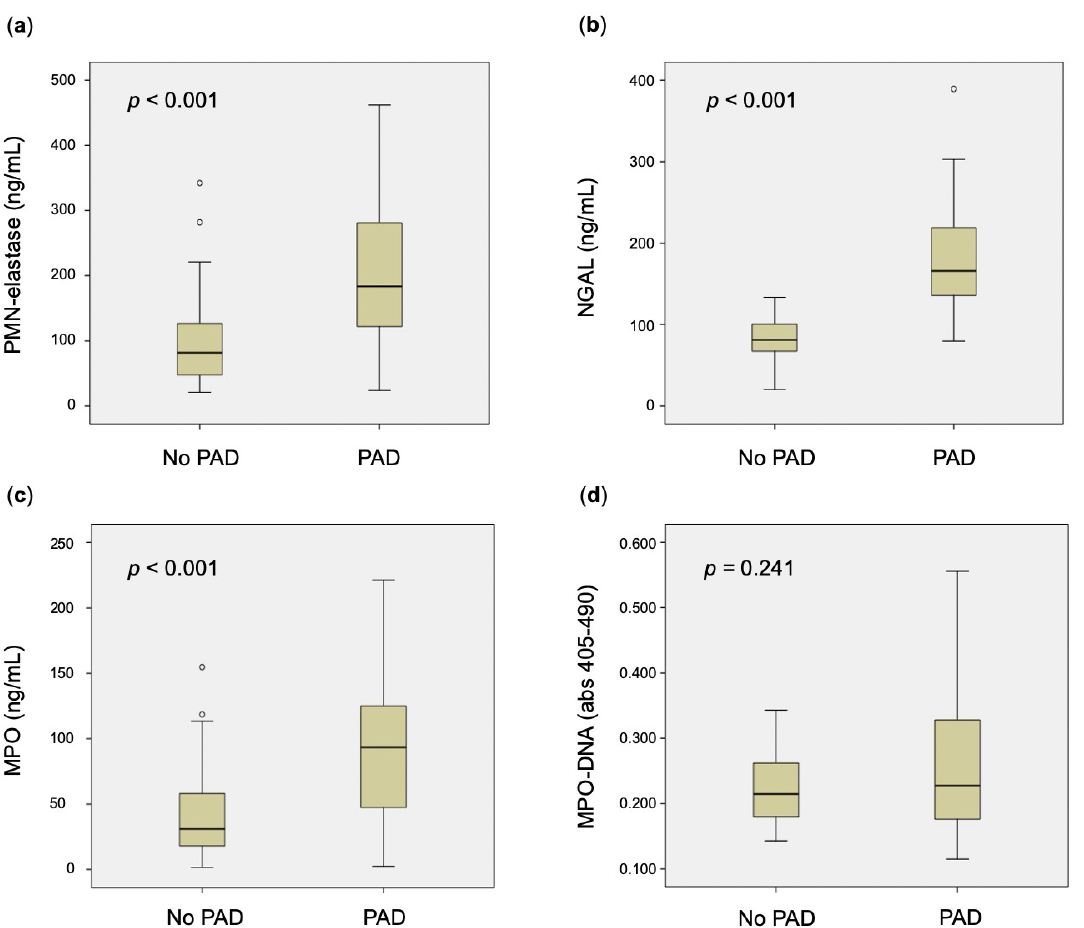
Figure 1. Markers of neutrophil activation, namely PMN-elastase ( a ), NGAL ( b ), MPO ( c ), and MPO–DNA ( d ) in subjects with and without symptomatic chronic PAD. Outliers are represented as small circles. Extreme outliers (95th percentile) may not be displayed in the figures. MPO: myeloperoxidase; NGAL: neutrophil gelatinase-associated lipocalin; PAD: peripheral artery disease; PMN: polymorphonuclear neutrophil.